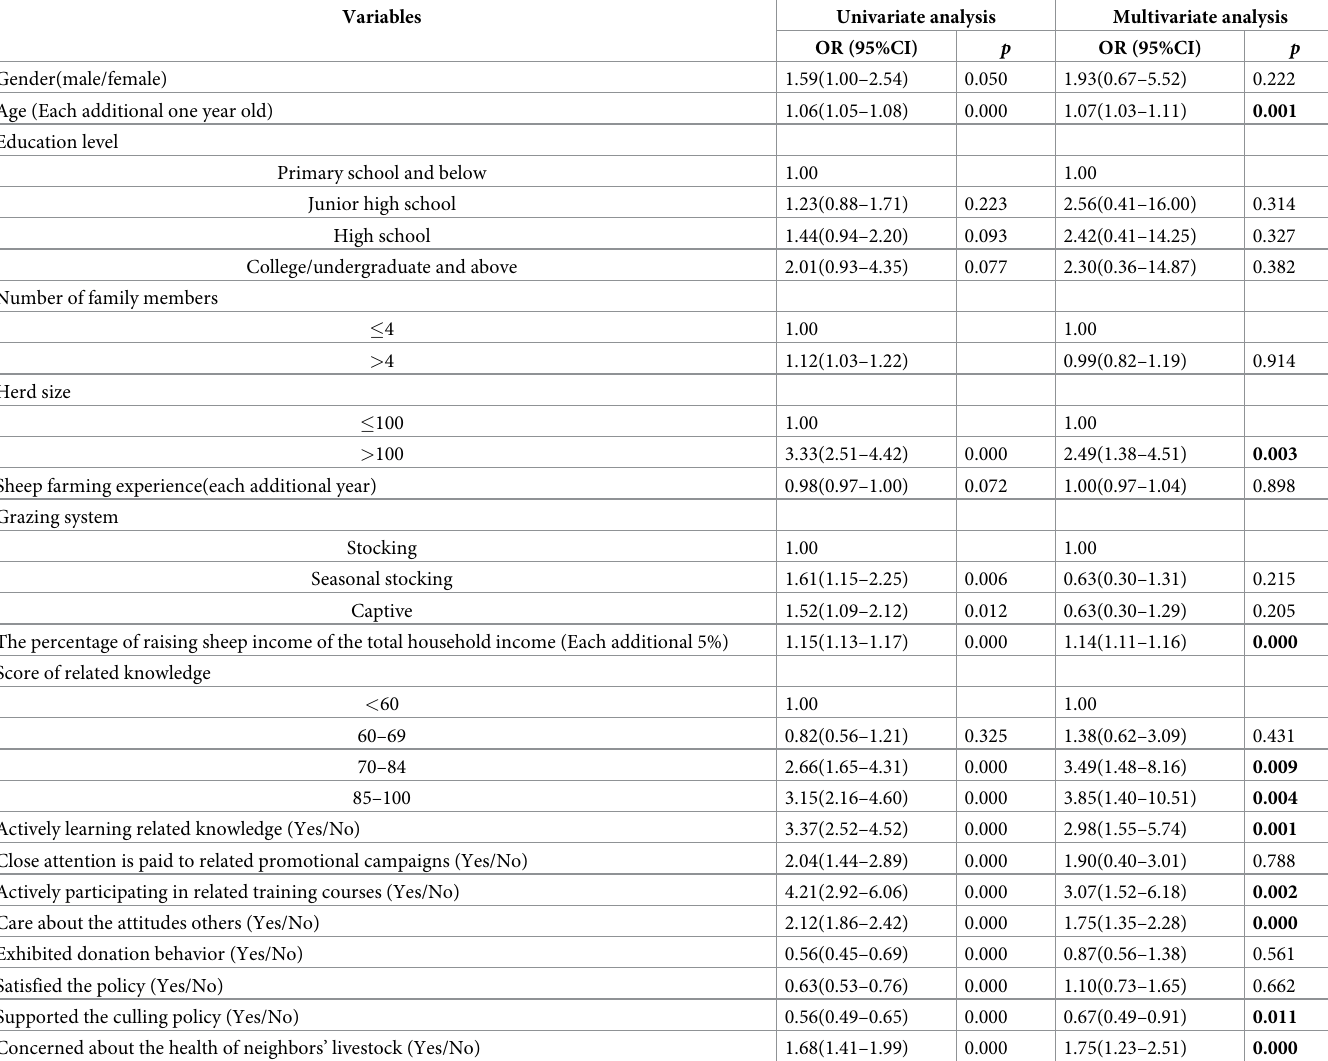
Table 3. Factors associated with households’ private investment in the prevention and control of sheep brucellosis (univariable and multivariable